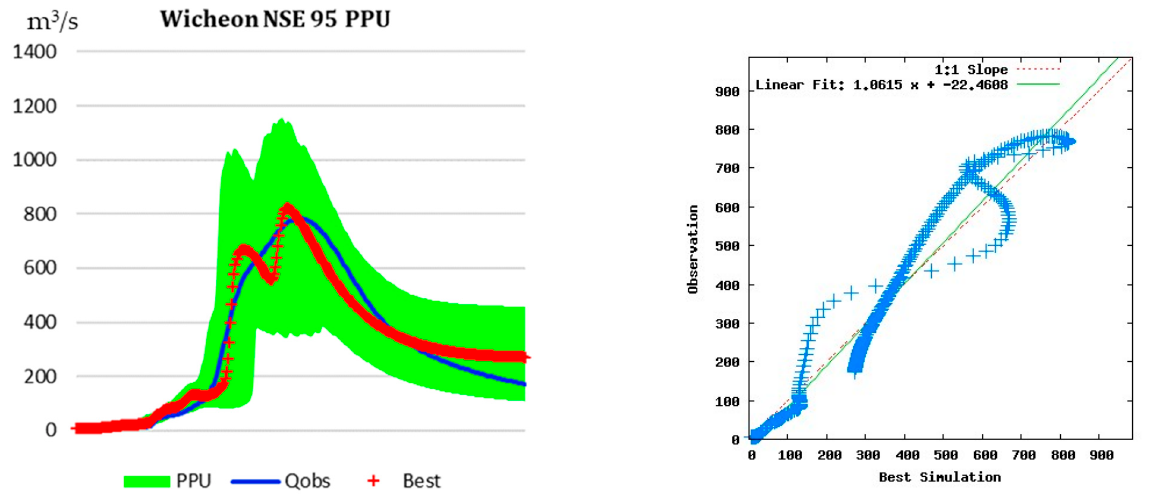
Figure 9. NSE 95 PPU for uncertainty of L 2 -based behavior model.